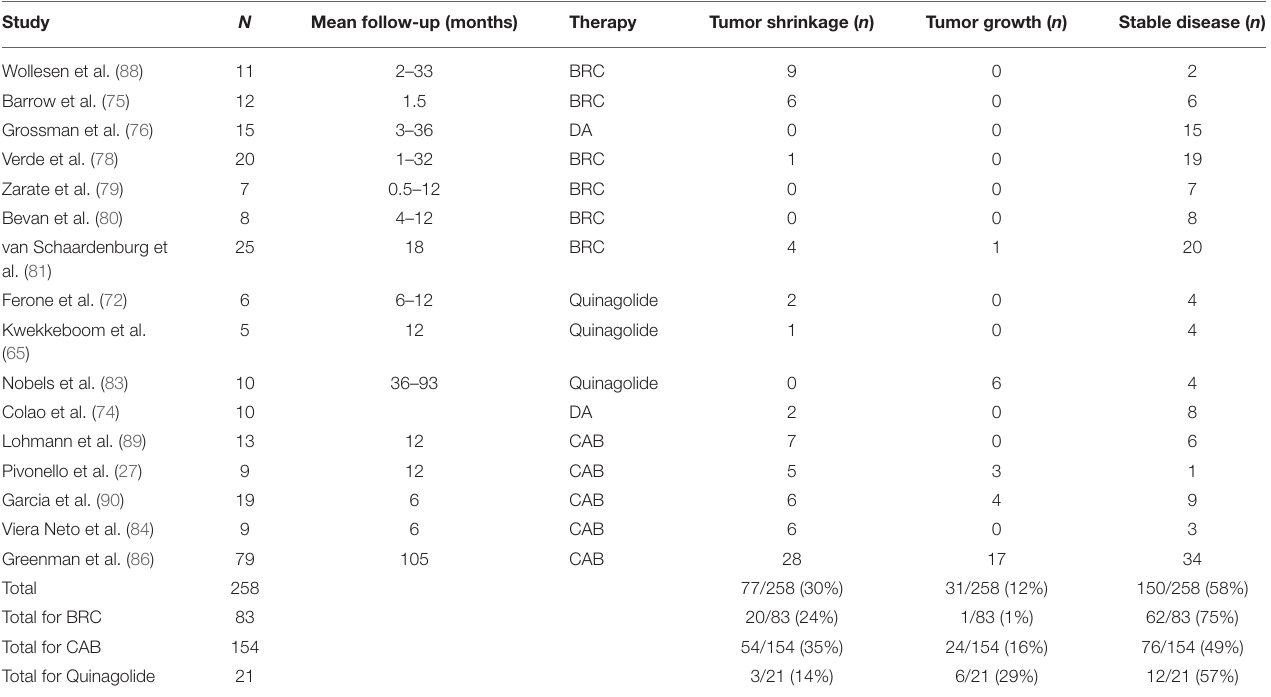
TABLE 2 | Response to dopamine agonists in